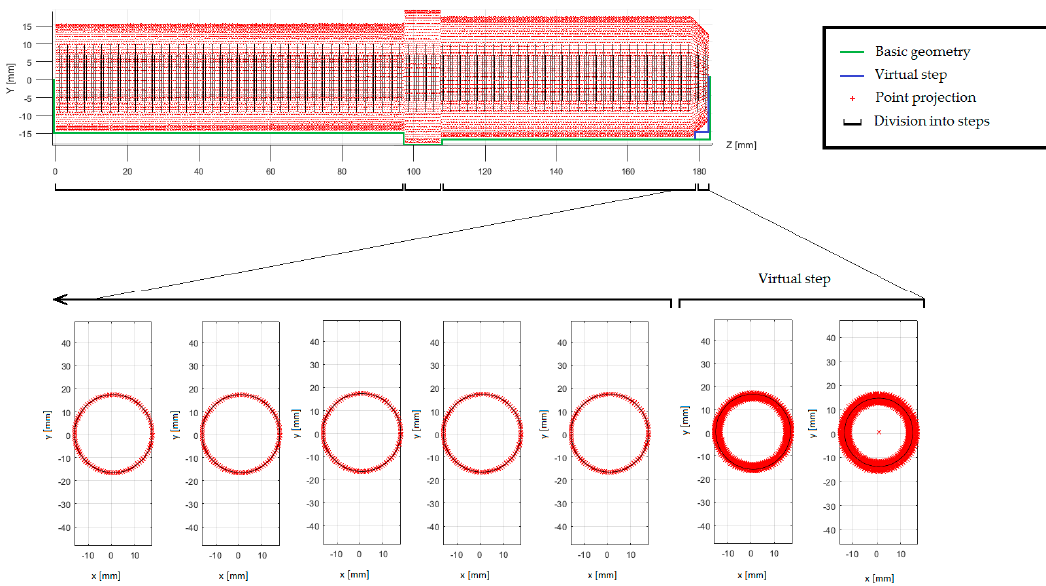
Figure 8. Overview of matched cross-sections with the apparent degree shown.